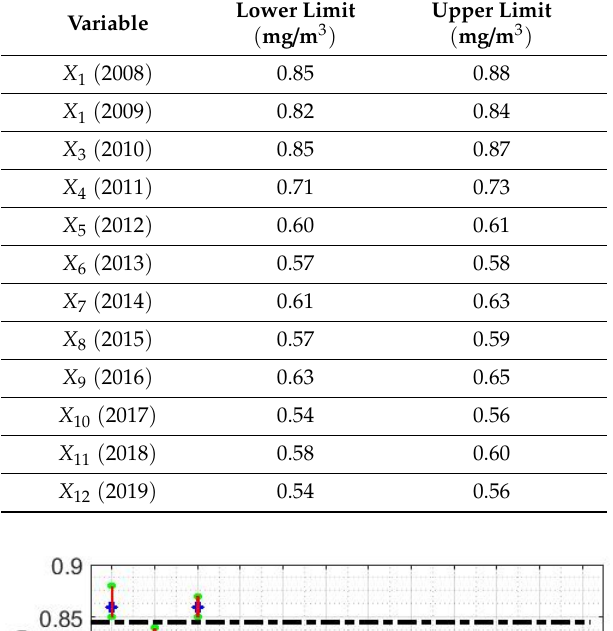
Table 2. Confidence interval limits for the median of each variable, with (cid:2009) = 0.05 . Variable